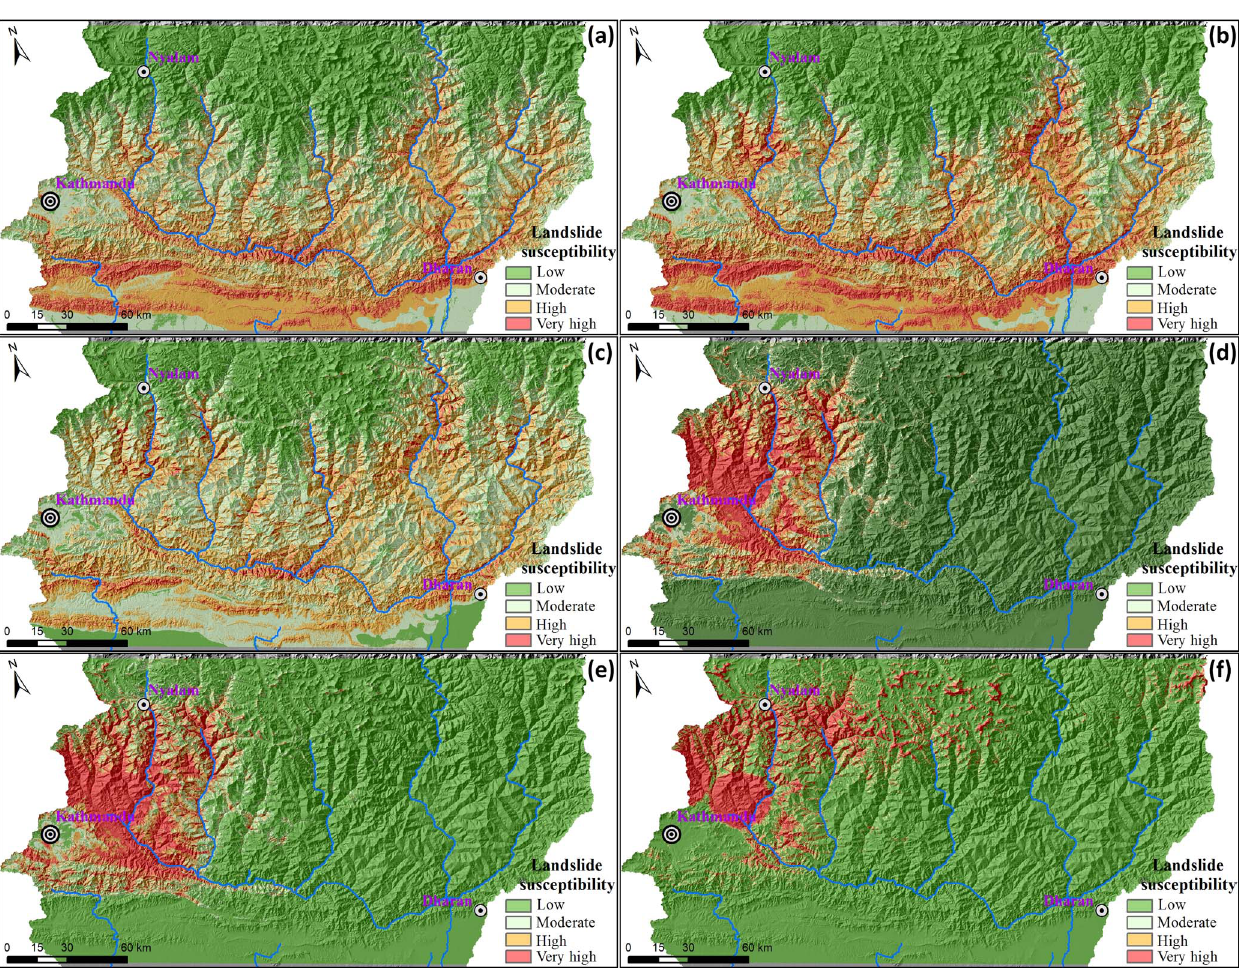
Figure 9. Susceptibility maps for different sizes of RTLs and ETLs (a) for all RTLs, (b) for small RTLs, (c) for large RTLs, (d) for all ETLs, (e) for small ETLs and (f) for large ETLs.